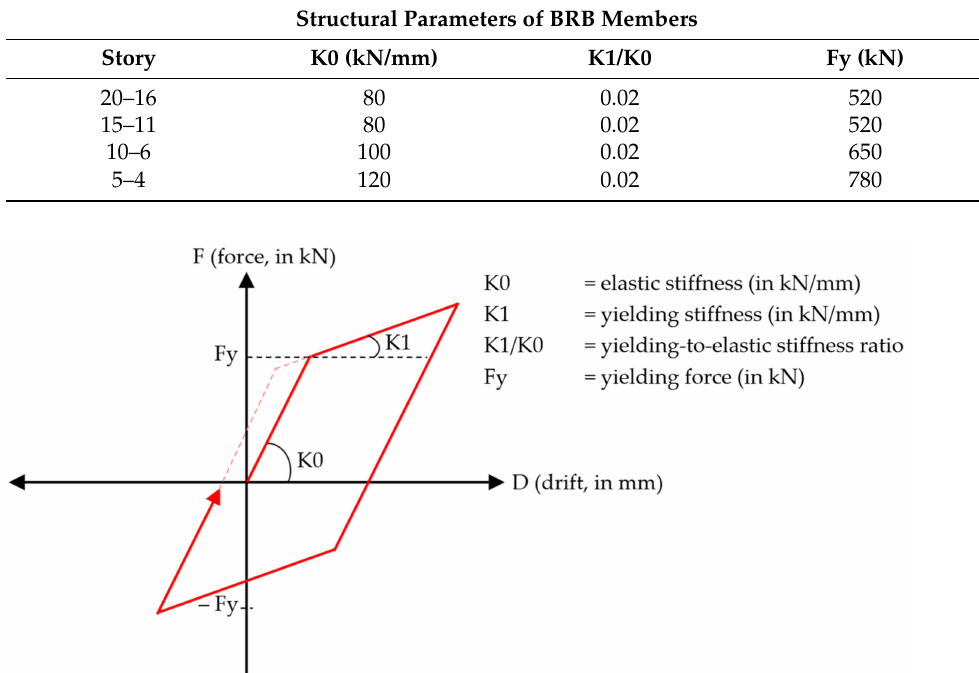
Figure 19. The adopted BRB’s bilinear